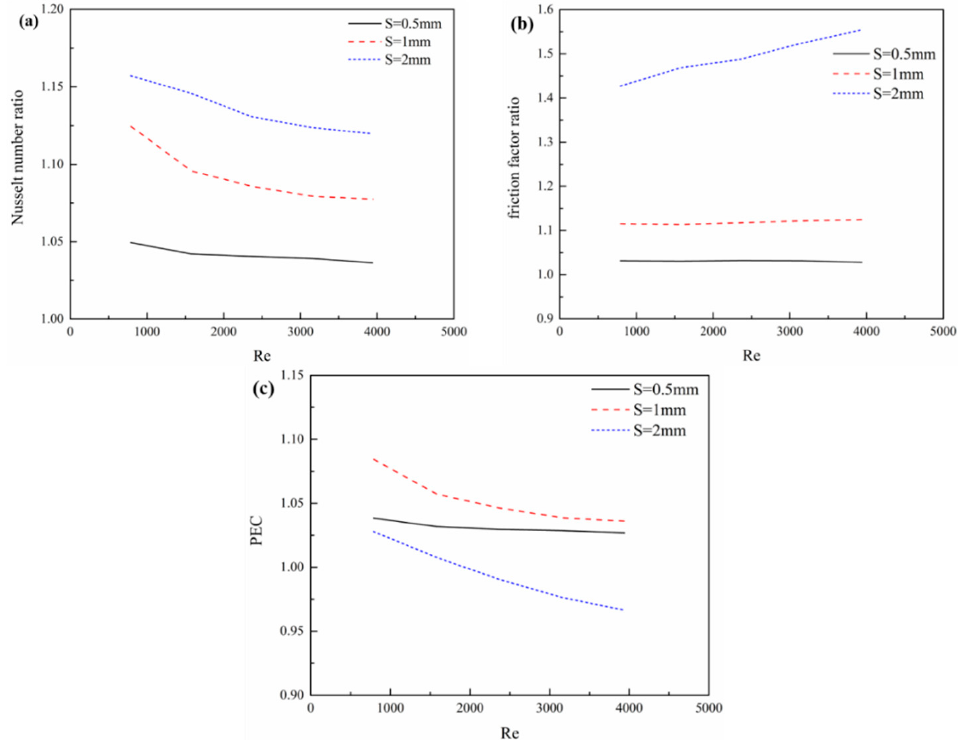
Figure 9. Influence of different breaking distance on heat transfer performance with Reynolds number.